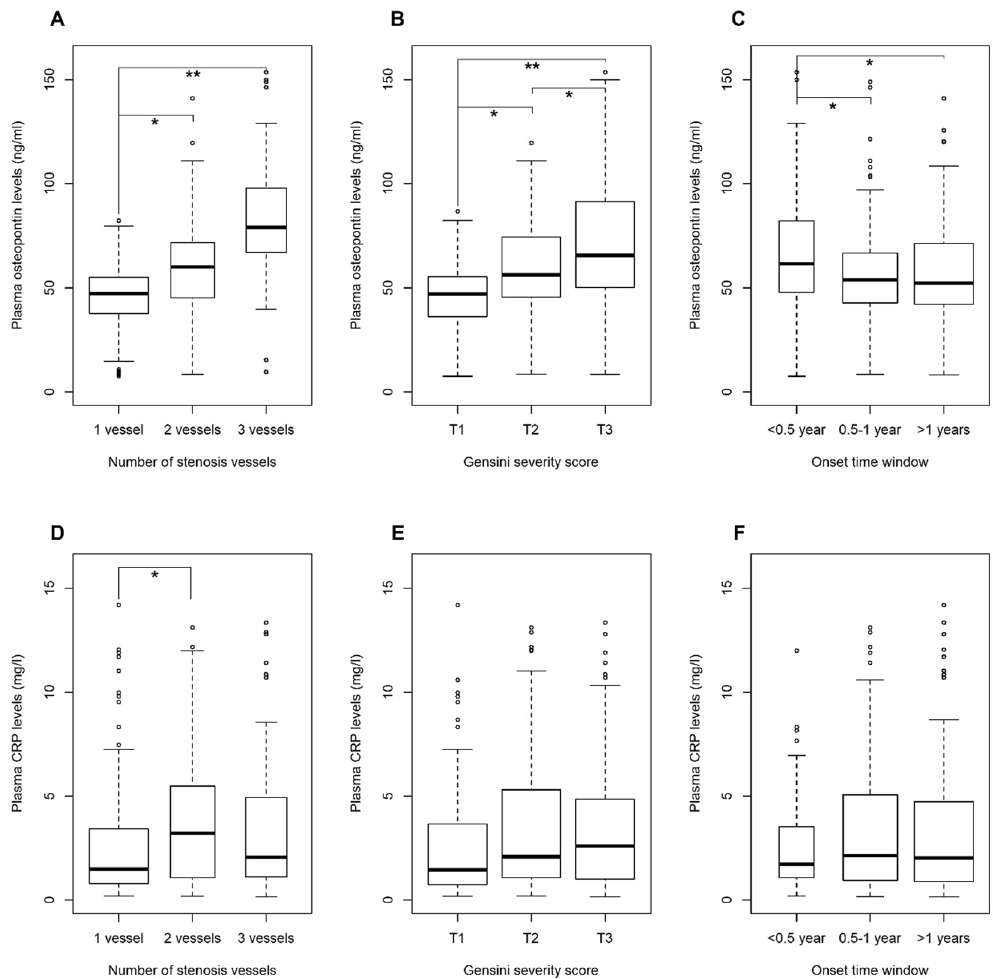
Figure 1. Association of Plasma Osteopontin and CRP Levels with ACS Severity and Onset Time Windows among ACS Cases in the Nested Case-control Study. Higher levels of circulating osteopontin were correlated with higher severity of ACS ( A and B ), and earlier ACS onset time (from the time of measurement to the ACS onset; C ). * represents P < 0.05 and ** represents P <